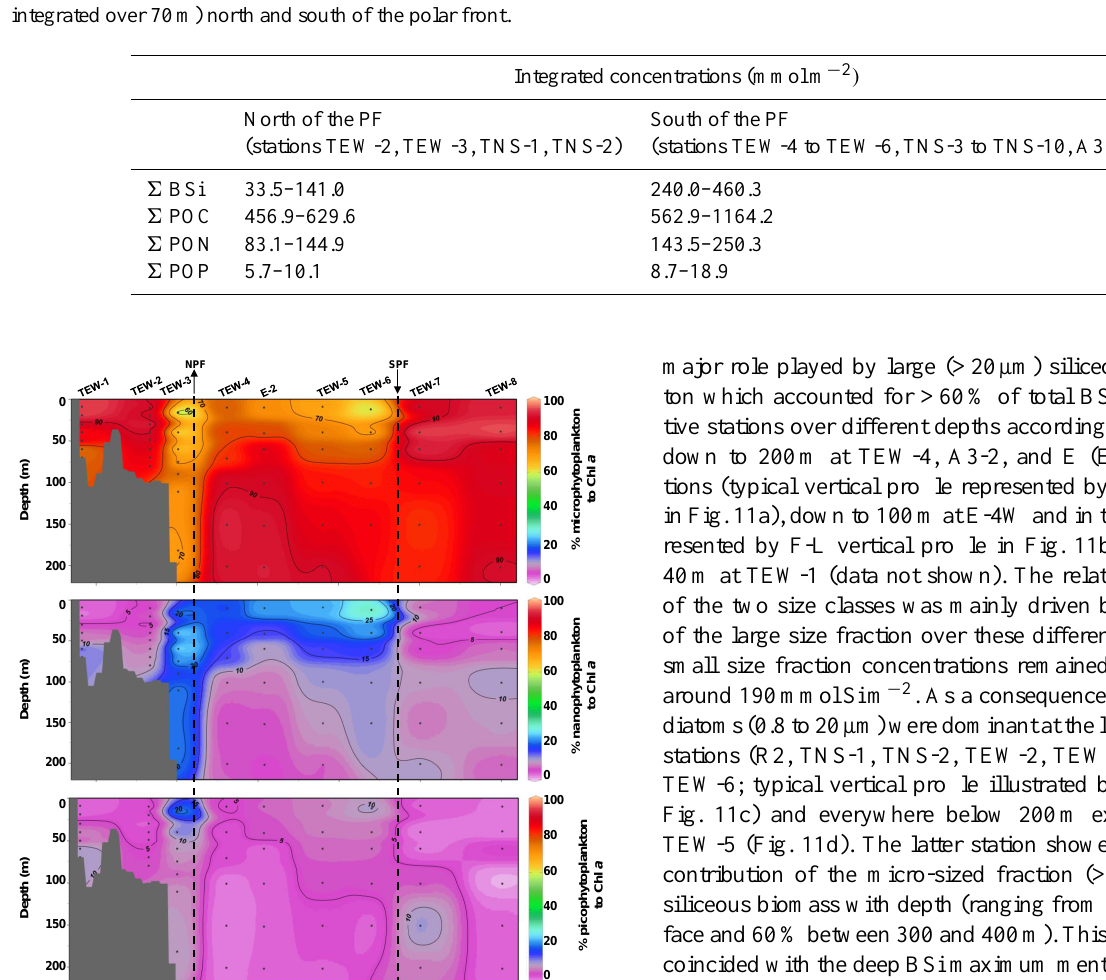
Table 1. Integrated concentrations in BSi, POC, PON, and POP (in mmolm − 2 ) over 200m depth (except for the coastal station TEW-2, integrated over 70m) north and south of the polar front.